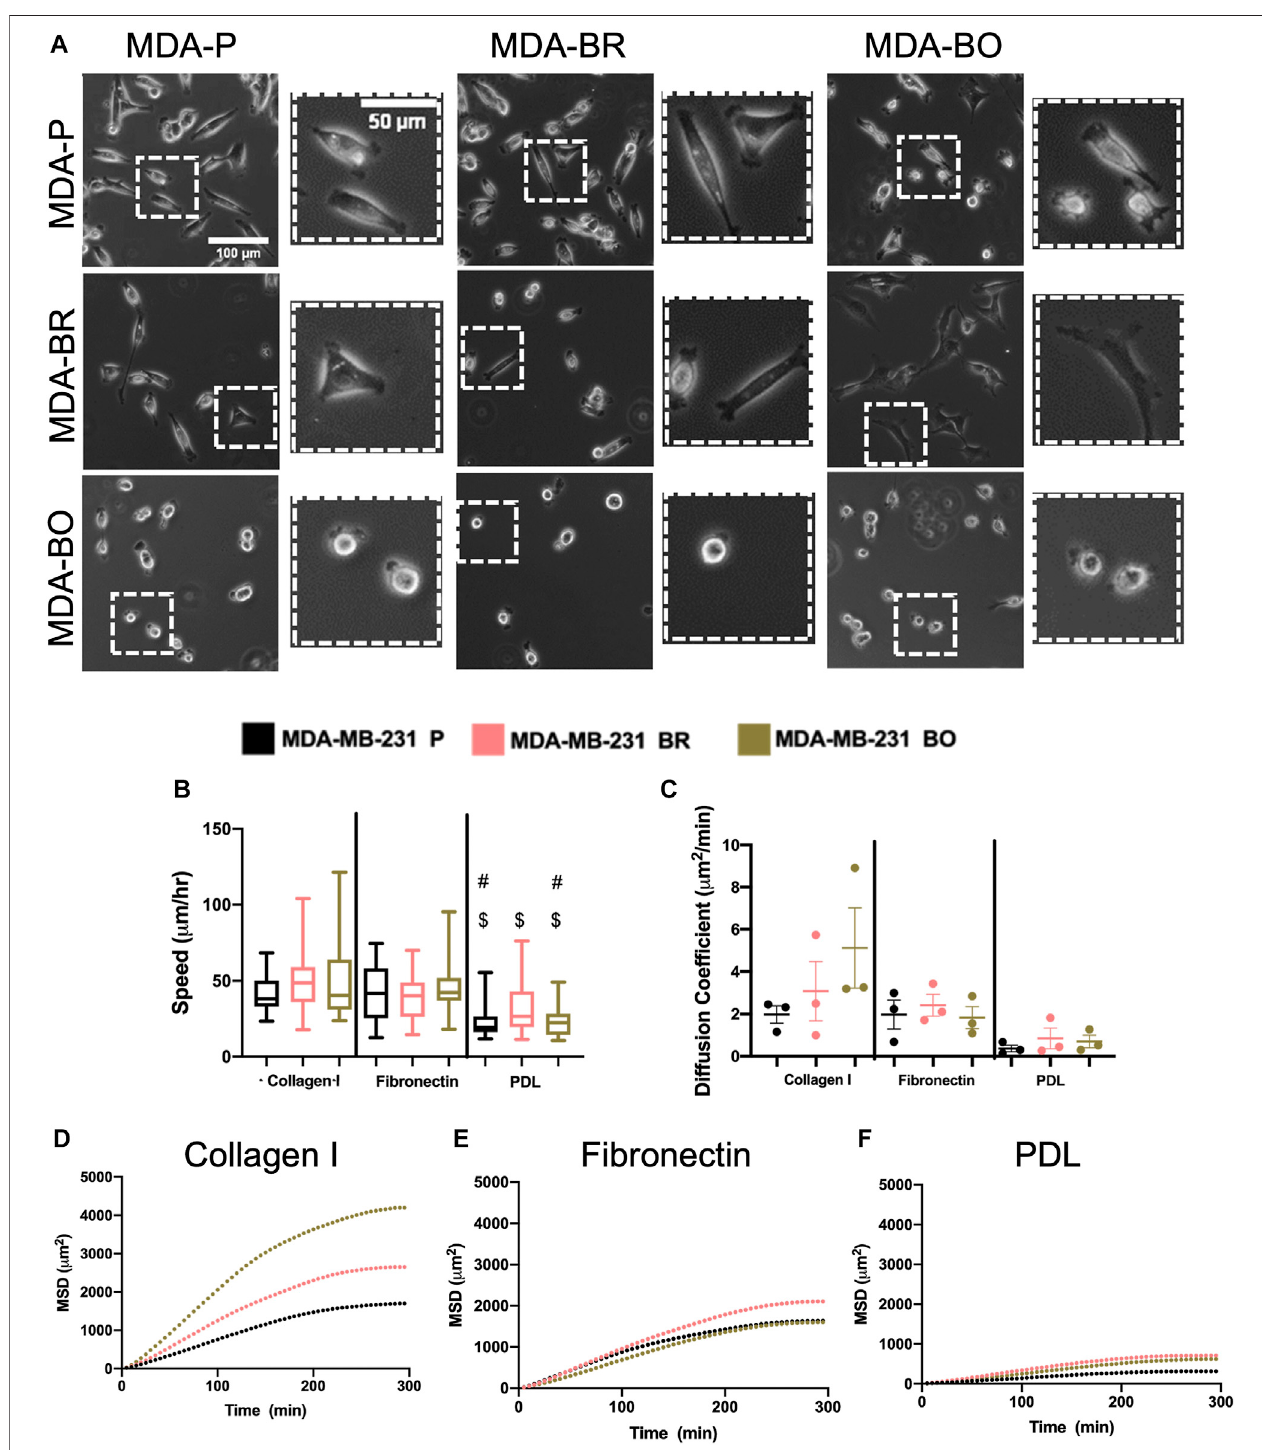
FIGURE 3 | 2D migratory characteristics on ECM binding proteins. (A) Phase contrast images of MDA-P, MDA-BR, and MDA-BO cells on Collagen I, Fibronectin, or PDL coated substrates. Scale bars represent 100 μ m (in zoomed out images) or 50 μ m (in zoomed insets). (B) Speed tracked for 360 min at 5-min intervals. Groups with # on top are different from corresponding cell type on Fibronectin substrate with p < 0.001. Groups with $ on top are different from corresponding cell type on Collagen I substrate with p < 0.001. (C) Diffusion coef fi cient calculated from mean squared displacement (MSD) vs. time data (over 300 min), as described in the Methodssection.AlsoshownismeanMSDvs.timeintervalplotsformigrationon (D) CollagenI, (E) Fibronectin,and (F) PDL.InpanelB,boxandwhiskerplotsrepresent the minimum and maximum data points, the median, and the interquartile range; each column of data is from N > 37 cells pooled from at least 3 independent experiments. Panel B data was tested for normality using the D ’ Agostino and Pearson test and found to be not normally distributed. A Kruskal Wallis test and a Dunn ’ s multiple comparison test was performed to determine signi fi cance.